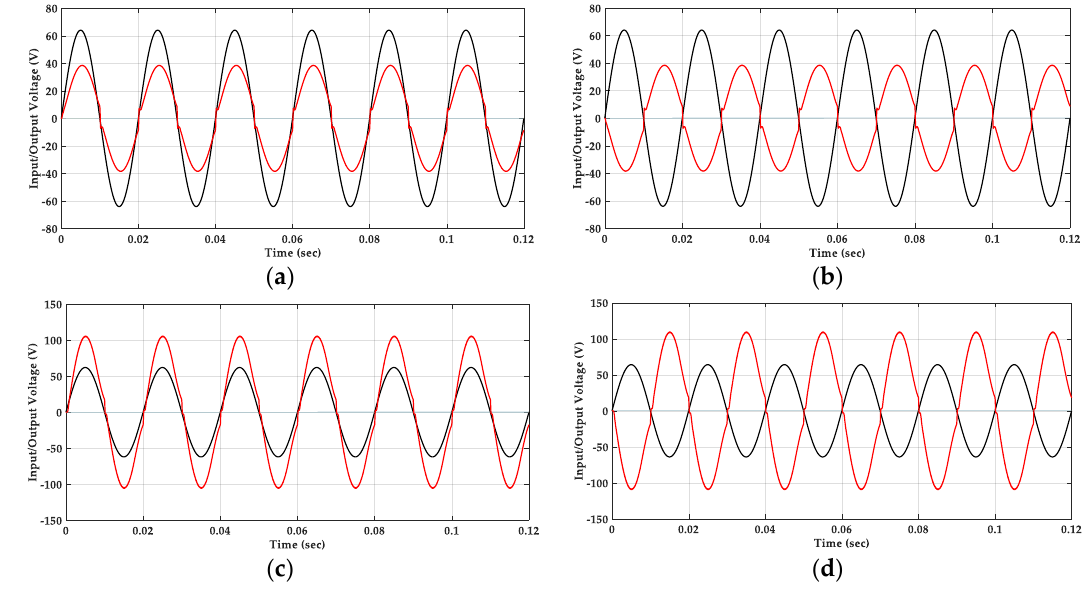
Figure 6. Input (black) and output (red) voltage ( a ) non-inverting buck mode; ( b ) inverting buck mode; ( c ) non-inverting boost mode; ( d ) inverting boost mode.